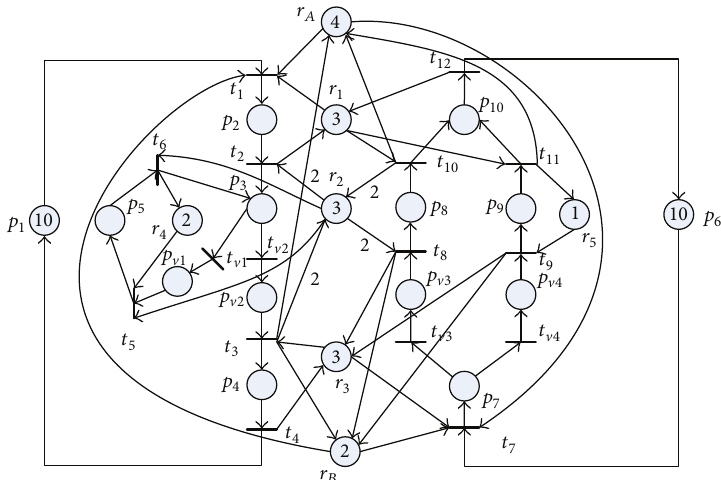
Figure 1: An OSC-S ∗ PR